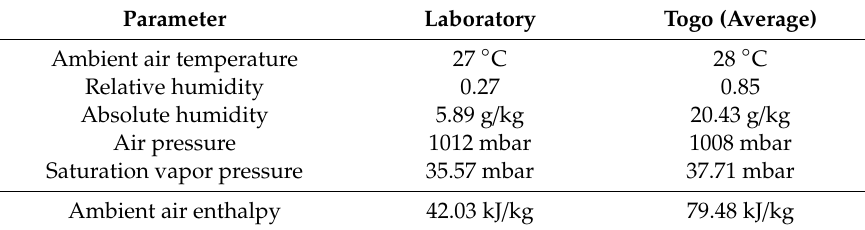
Table 8. Climatic conditions in the laboratory and in Togo (average).